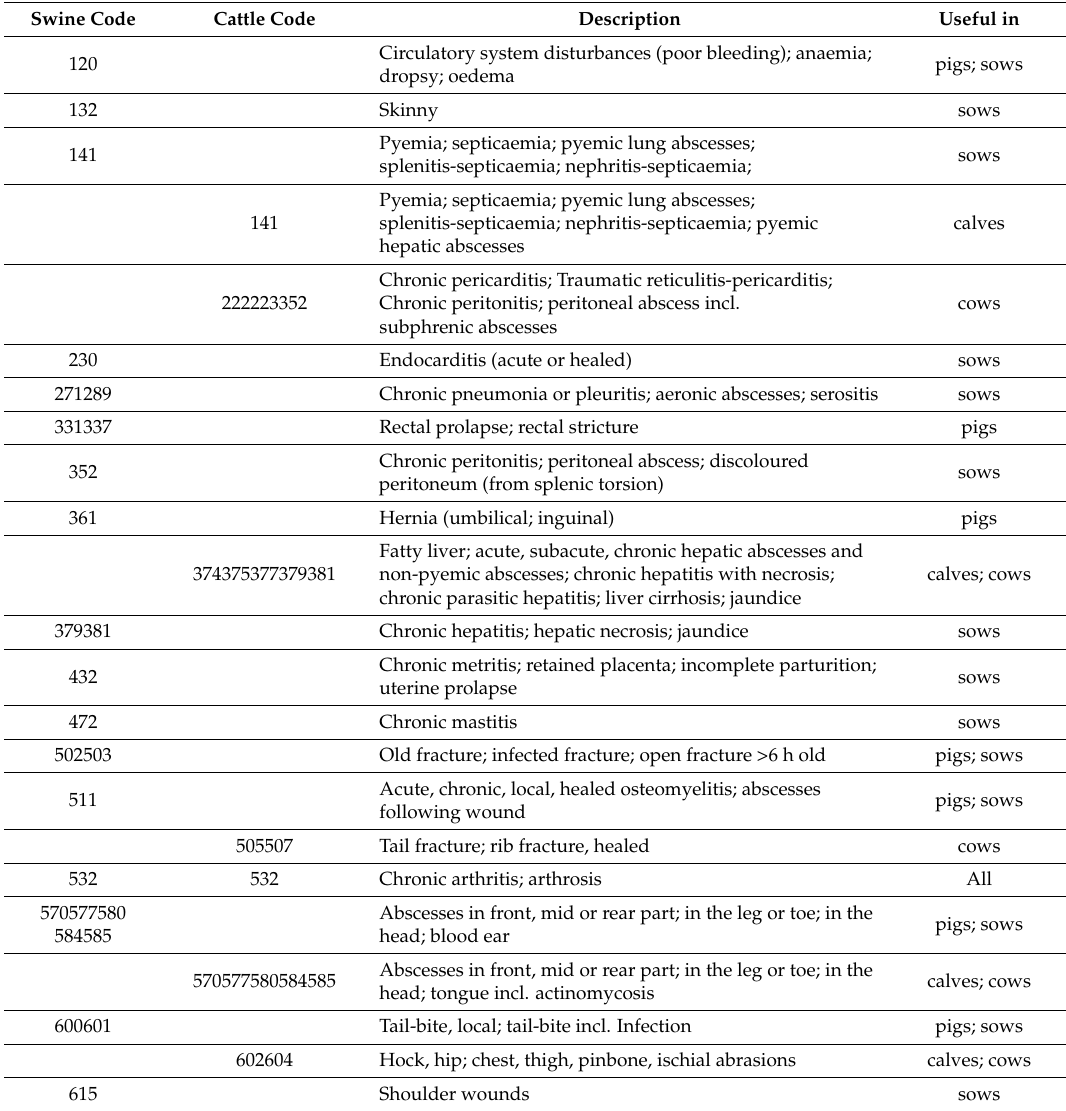
Table 8. Meat inspection codes deemed potentially useful for welfare related purposes given that they are accurate, while the abattoir effect is significant for most but still within a relatively small